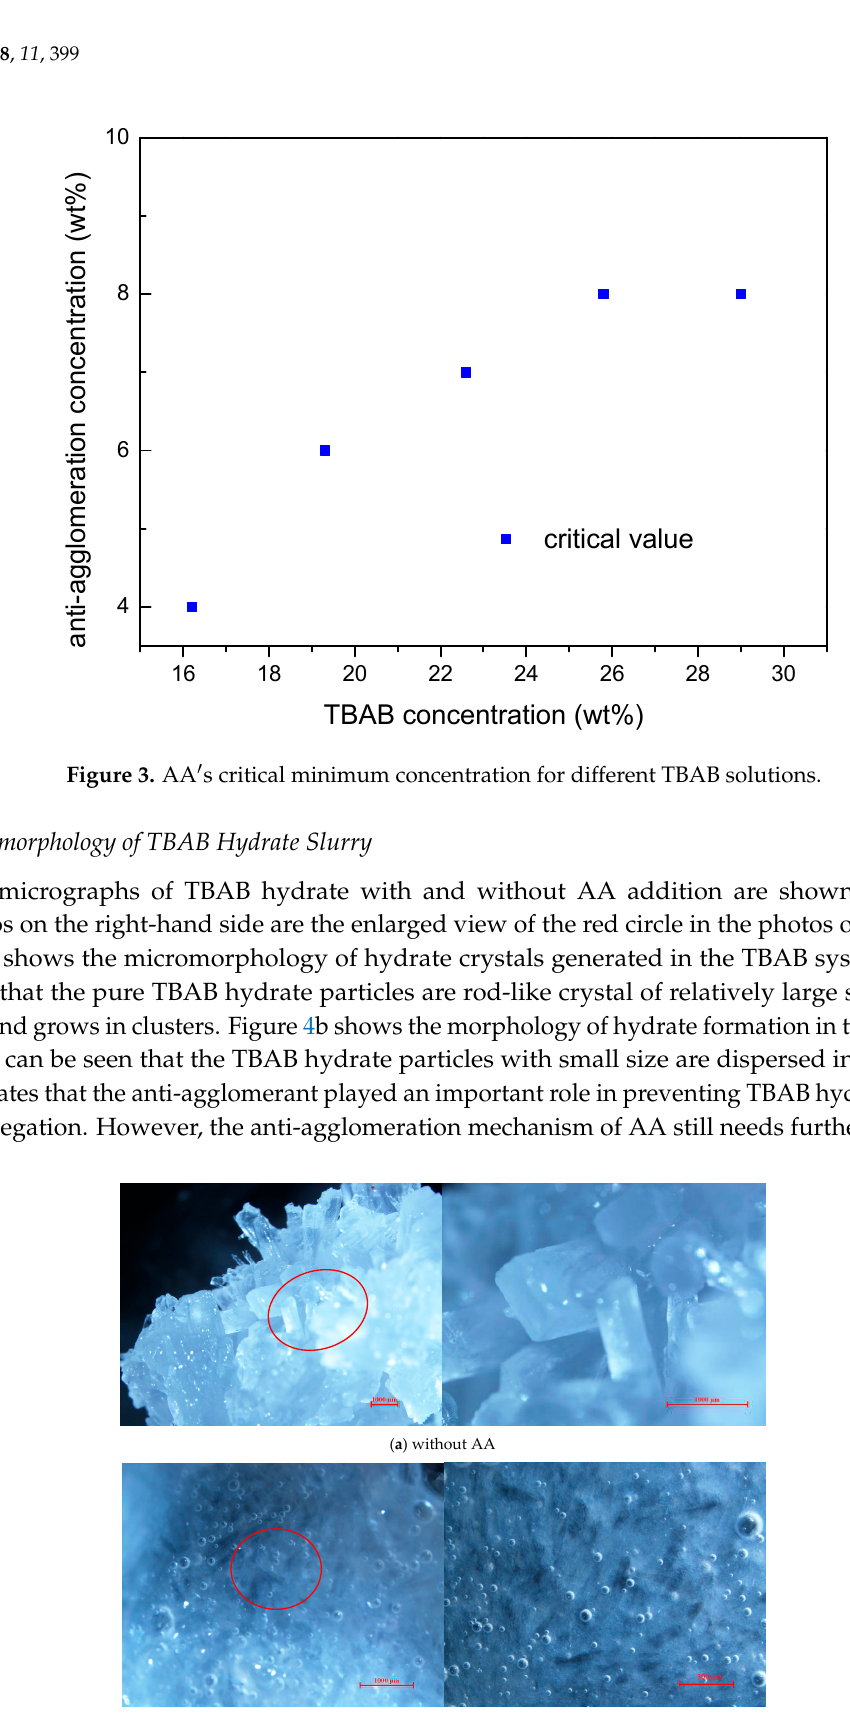
Figure 4. Micrographs of TBAB hydrate.